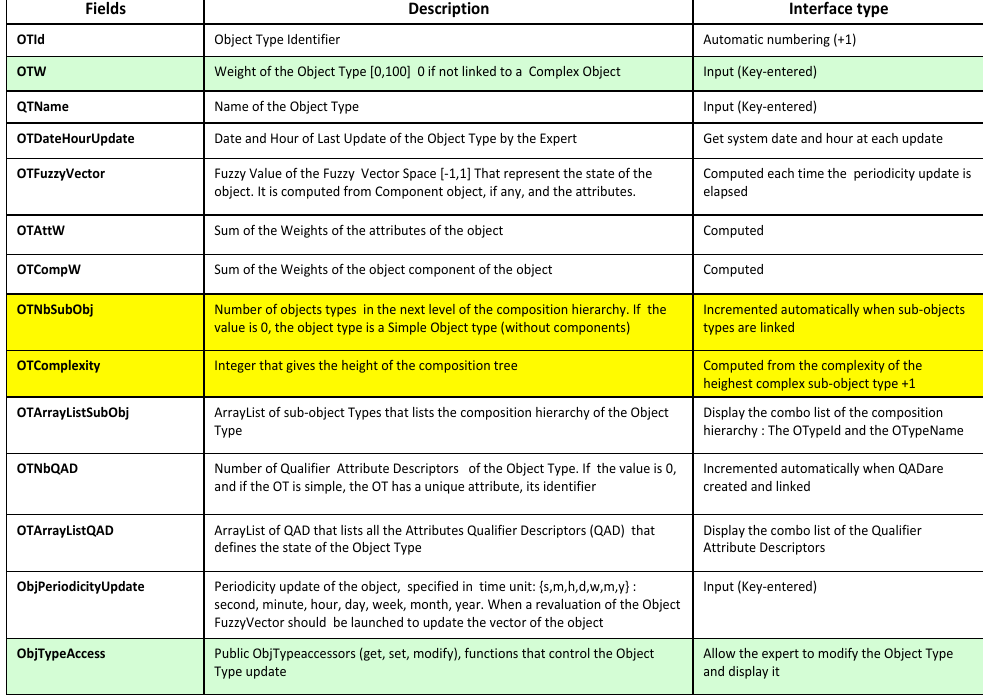
Figure 6. Expert interface: object type descriptor (OTD).